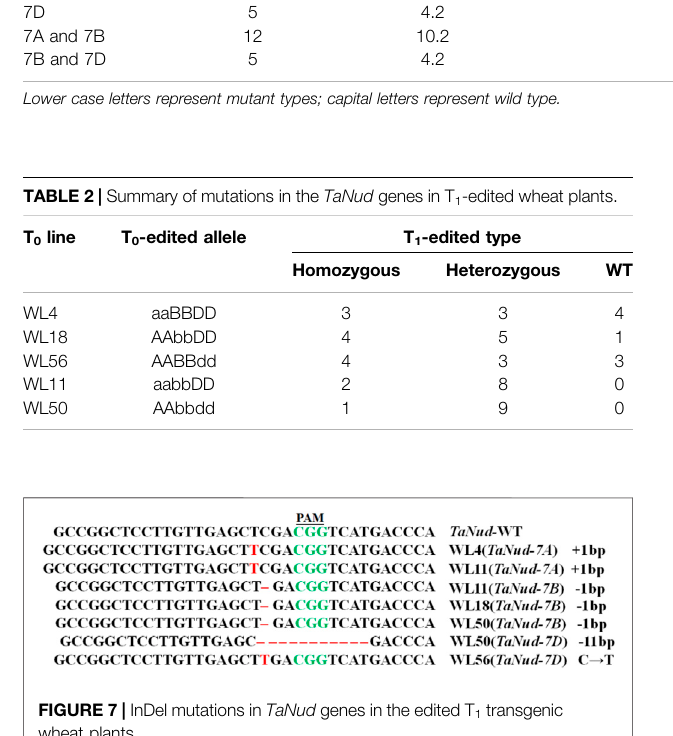
TABLE 1 | Summary of the mutations of the TaNud genes in T 0 -edited wheat plants. Mutation allele Mutant plant